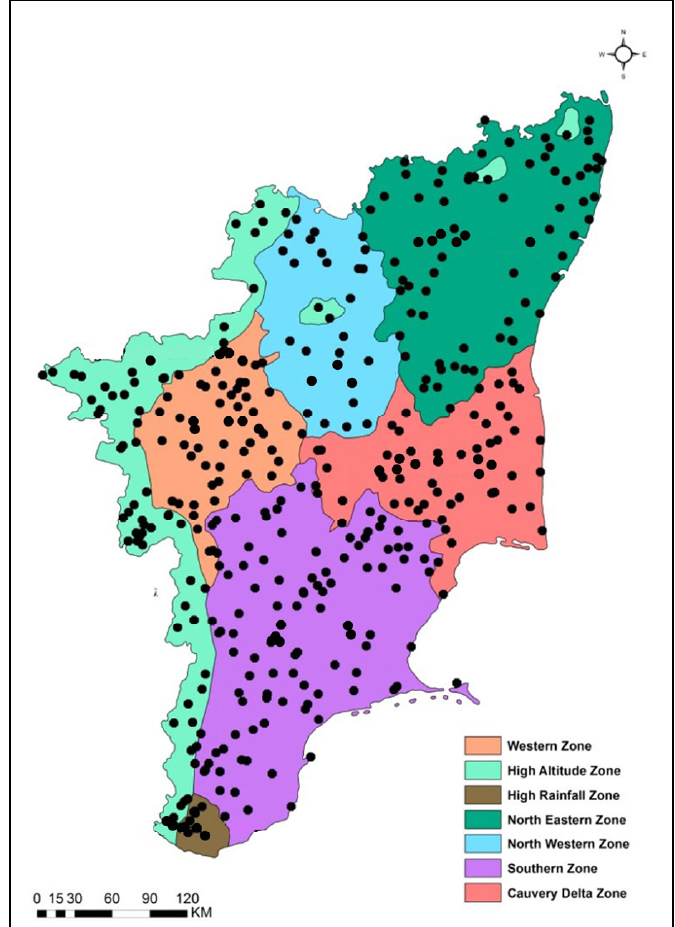
Figure 2. In-situ rain gauge distribution in di ff erent zones of Tamil Nadu .